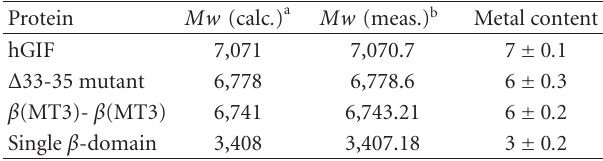
Table 1: Mass spectrometry analysis and metal contents of hGIF and its